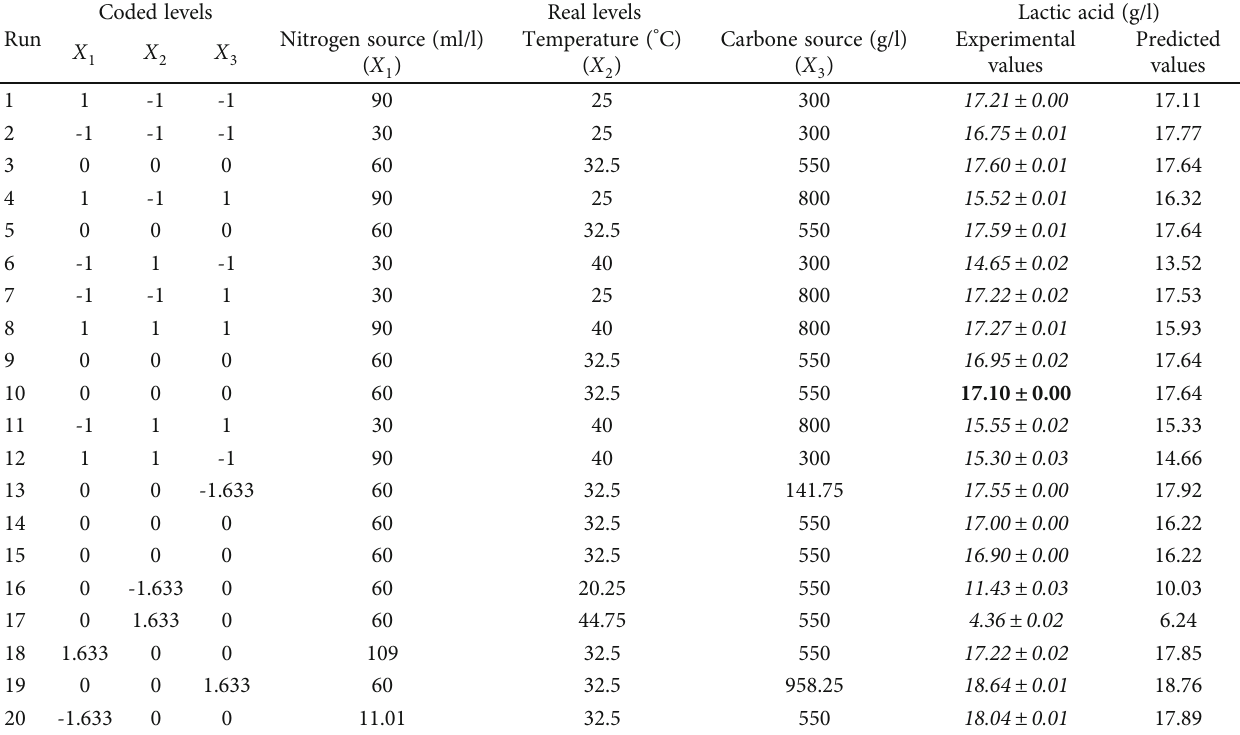
Table 3: Experimental design for the optimization process of lactic acid